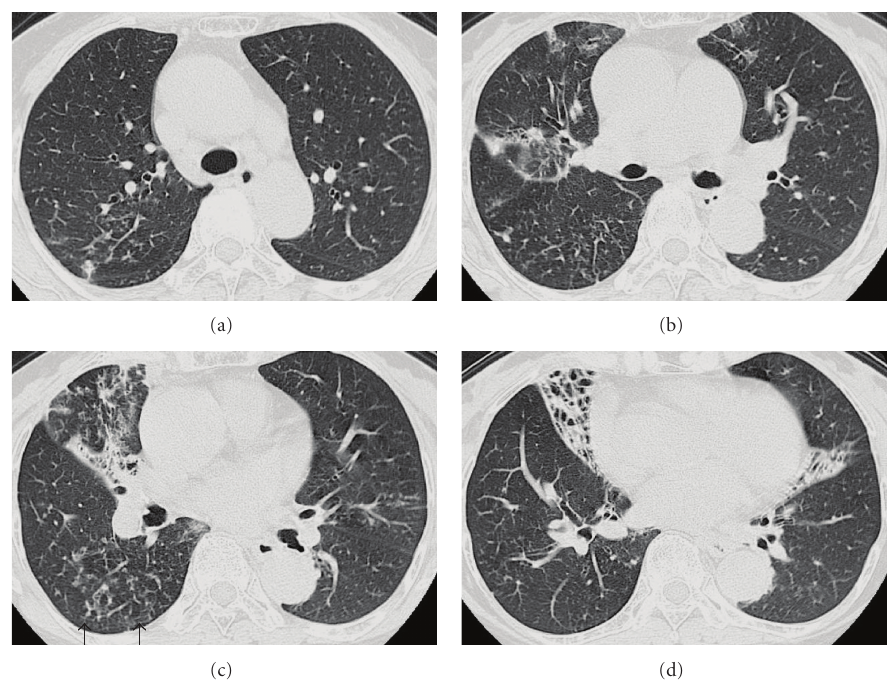
Figure 1: High-resolution CT revealed centrilobular micronodular opacities (right S 2 and S 3 , right S 6 and S 9 , and left upper lobe) (a, b, and c) and volume loss with bronchial wall thickening and bronchiectatic changes in both the right middle lobe and left lingual (d). Biopsied specimens were obtained from the area indicated by arrows (c).